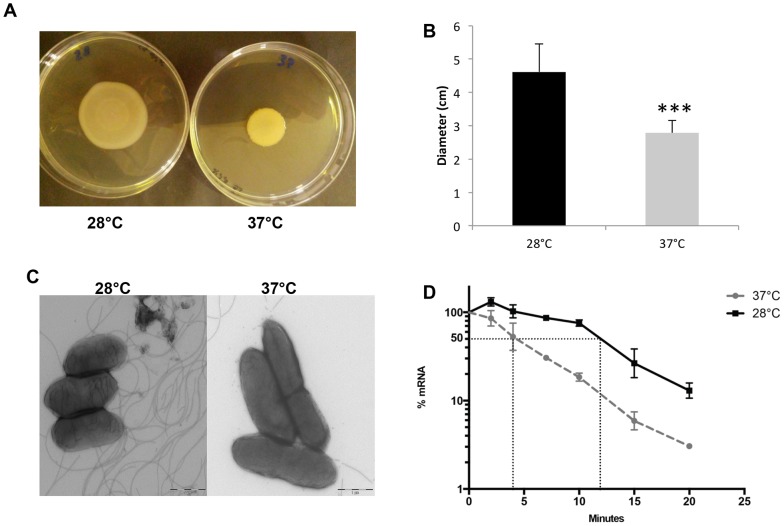
Temperature-dependence of cellular motility and fliC gene regulation.Motility assays on LB soft 0.4% agar plates as from a typical experiment (A) and quantitative estimate from an average of six independent experiments (B). Statistical analysis (two-tailed Student’s t test) of the results provided a p value<0.0001 (indicated by the three asterisks in the figure). C: TEM observation of cells from BtCDC272 overnight cultures grown either at 28°C or 37°C. The 1 μm scale bar is shown in the right bottom corner of each panel. D: RNA stability assays on the transcript of the fliC gene, as determined using qRT-PCR. The horizontal dashed line indicates 50% of residual amount of mRNA after rifampicin addition; the vertical dashed lines define the half-life values. Values are the average of four experiments (two repeats, each performed on duplicate samples, from two independent experiments) and standard deviations are shown.